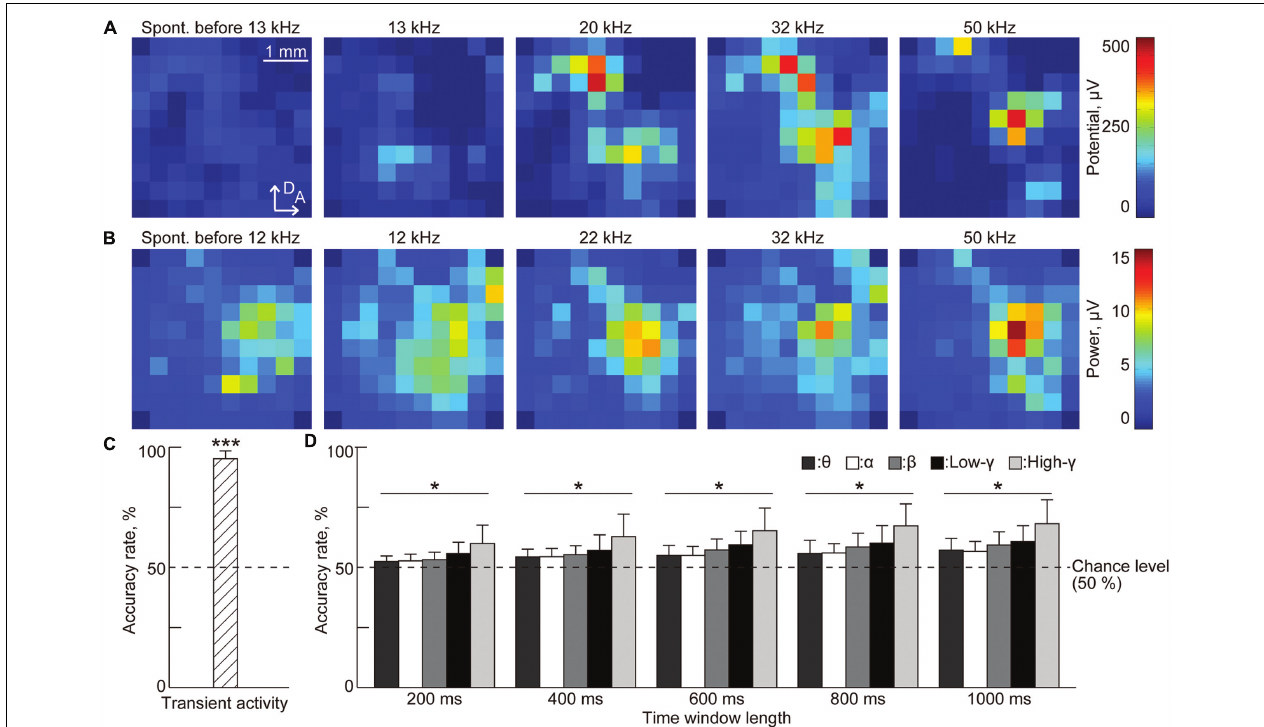
FIGURE 5 | Sparse logistic regression decoding from transient activities and the band-specific power of sustained activities. (A) Representative spatial patterns of transient potentials in spontaneous activity (leftmost) and in response to varied test frequencies: 13, 20, 32, and 50 kHz. (B) Representative spatial patterns of high-gamma power for 1,000 ms in spontaneous activity (leftmost) and in response to varied test frequencies: 12, 22, 32, and 50 kHz. (C,D) Decoding accuracy (C) in transient activities and (D) in band-specific power. For band-specific power, both the bands and the time window length were varied. Asterisks indicate that decoding performance was better than the chance level, i.e., 50%: ∗∗∗ p < 0.001 (Wilcoxon signed-rank test), ∗ p < 0.05 (Wilcoxon signed-rank test). Spont., spontaneous activity.